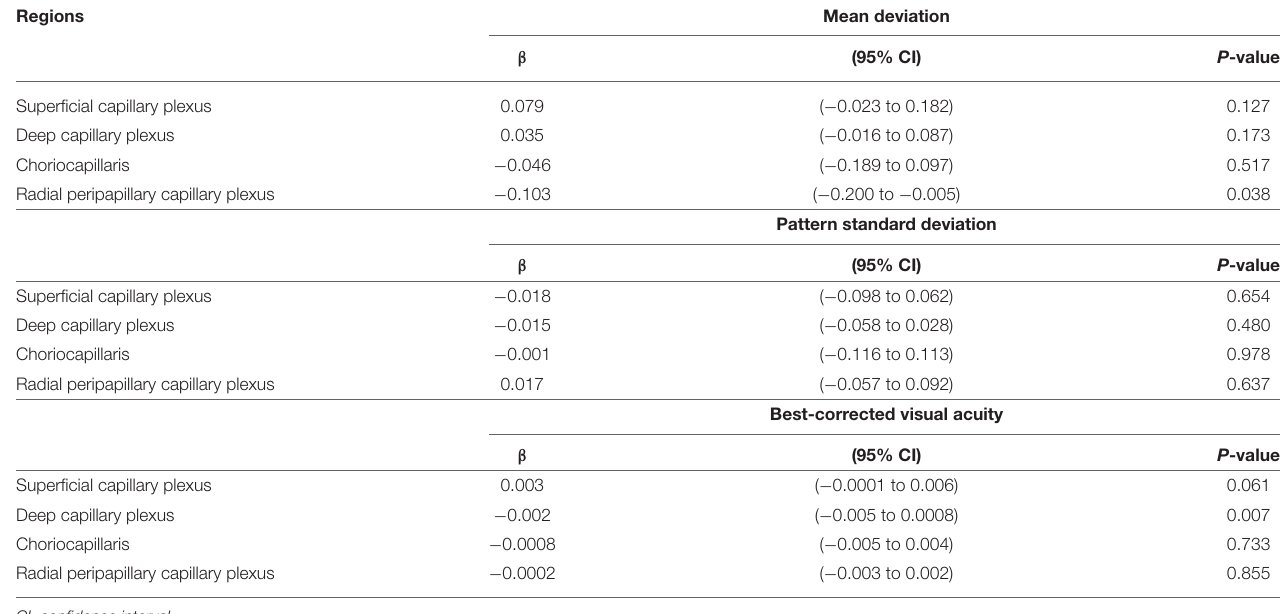
TABLE 3 | Correlations between vessel density, visual field, and visual acuity for MS patients. Regions